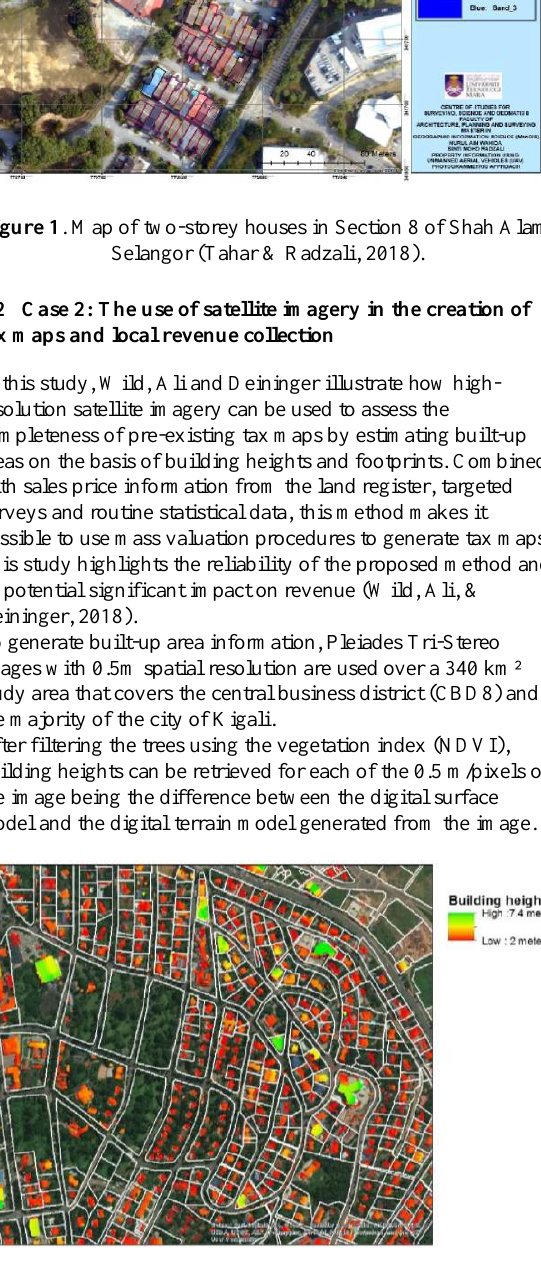
Figure 2 . Estimated building heights, Kigali center (Wild, Ali, & Deininger,